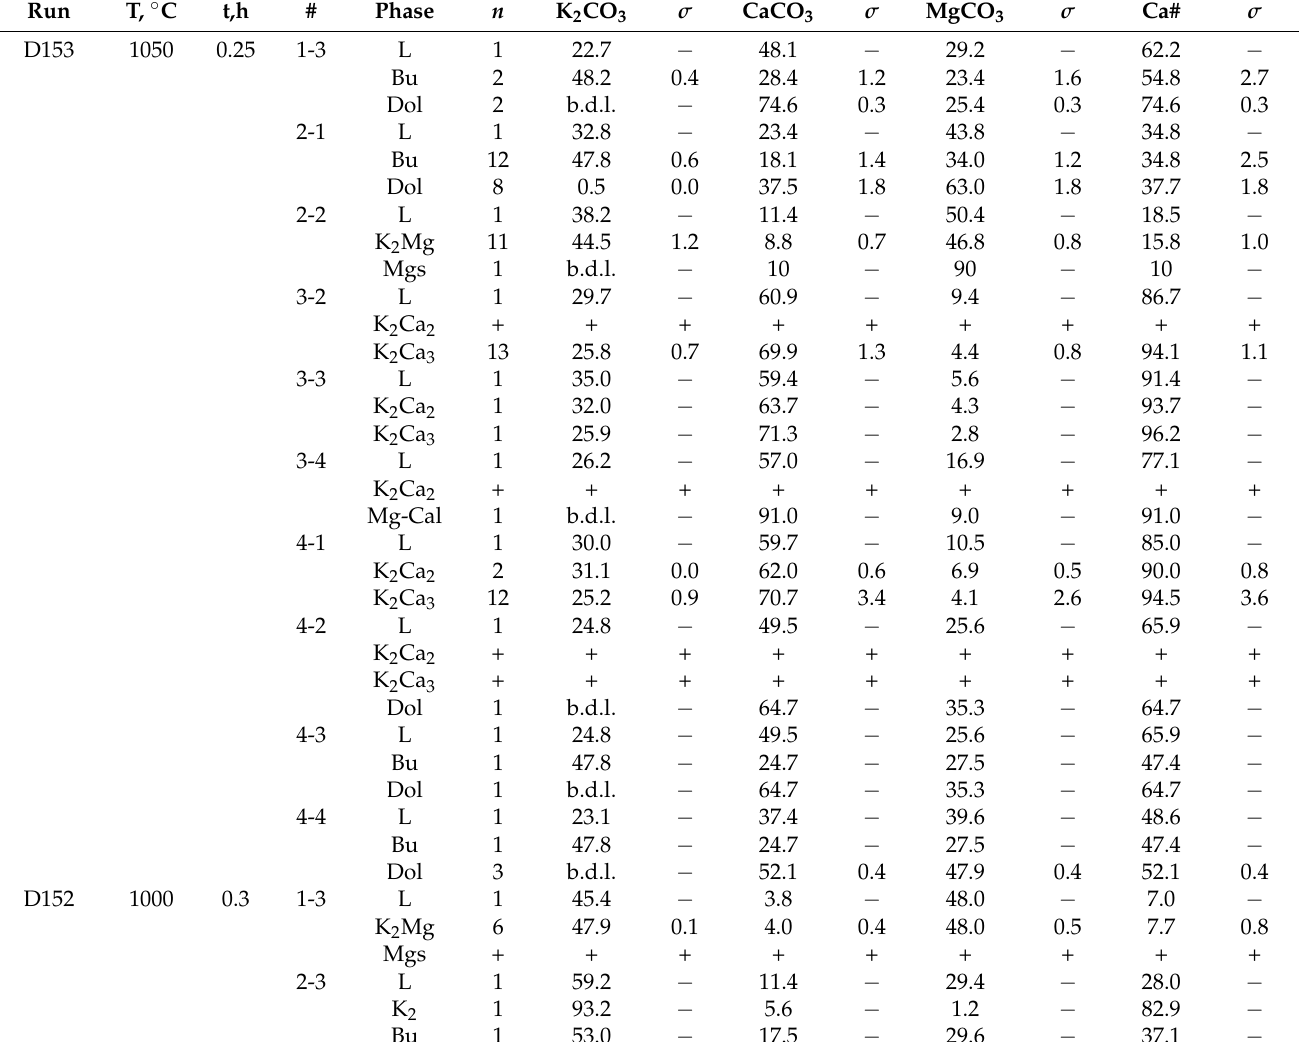
Table 2. Composition of quench products of K 2 CO 3 –CaCO 3 –MgCO 3 melt at 3